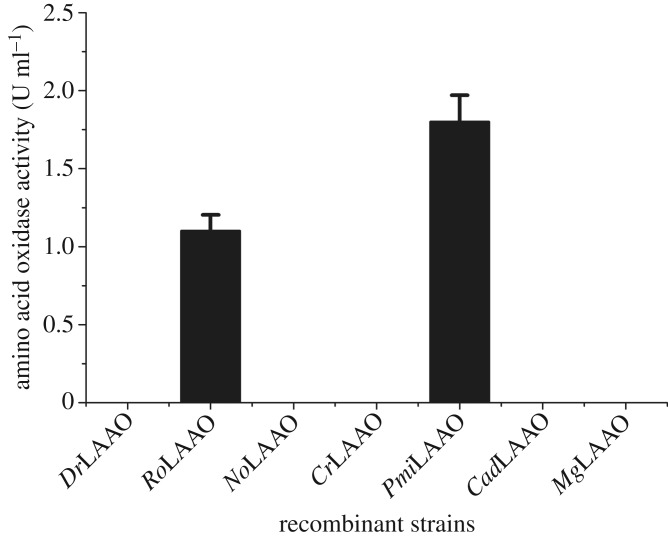
The amino acid oxidase (LAAO) activity of the recombinant strains. Amino acid oxidase NoLAAO, CrLAAO, CadLAAO, MgLAAO, RoLAAO, DrLAAO and PmiLAAO were from Naja oxiana, Calloselasma rhodostoma, Crotalus adamanteus, Meleagris gallopavo, Rhodococcus opacus, Daboia russellii and Proteus mirabilis, respectively.